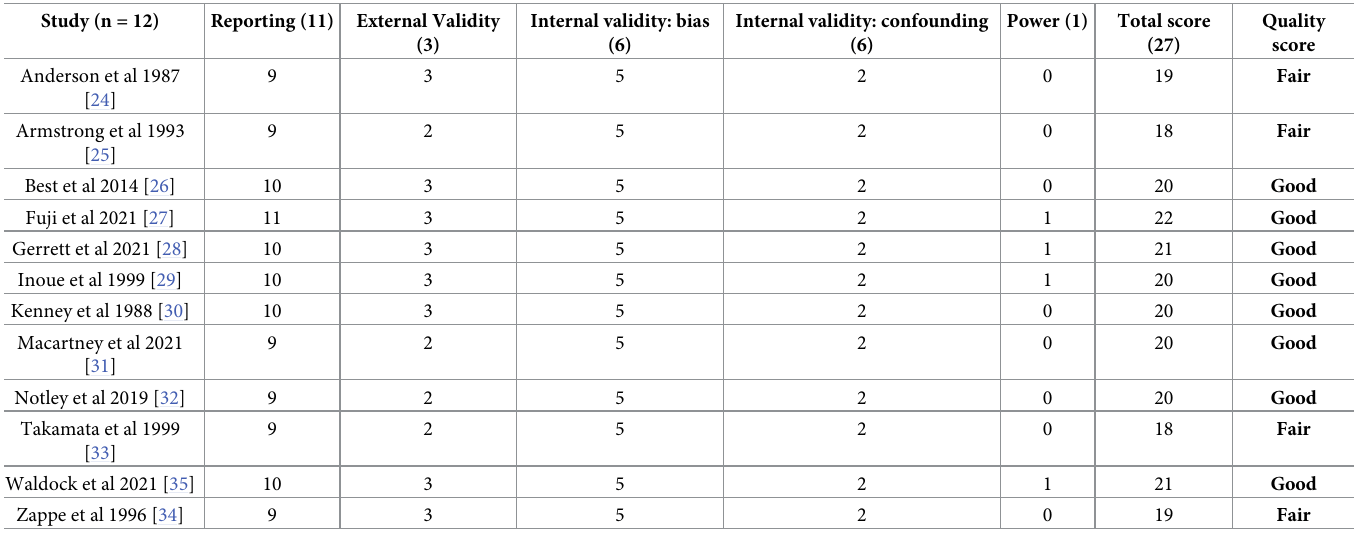
Table 3. Modified Downs and Black (1998) [36]